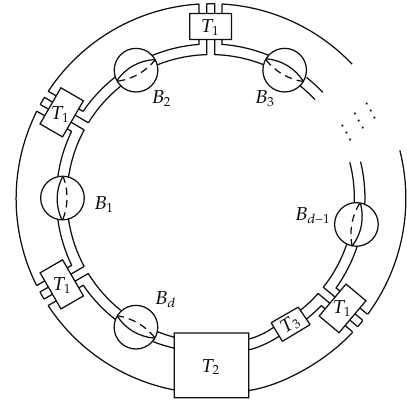
Figure 5: Tangle decompositions.